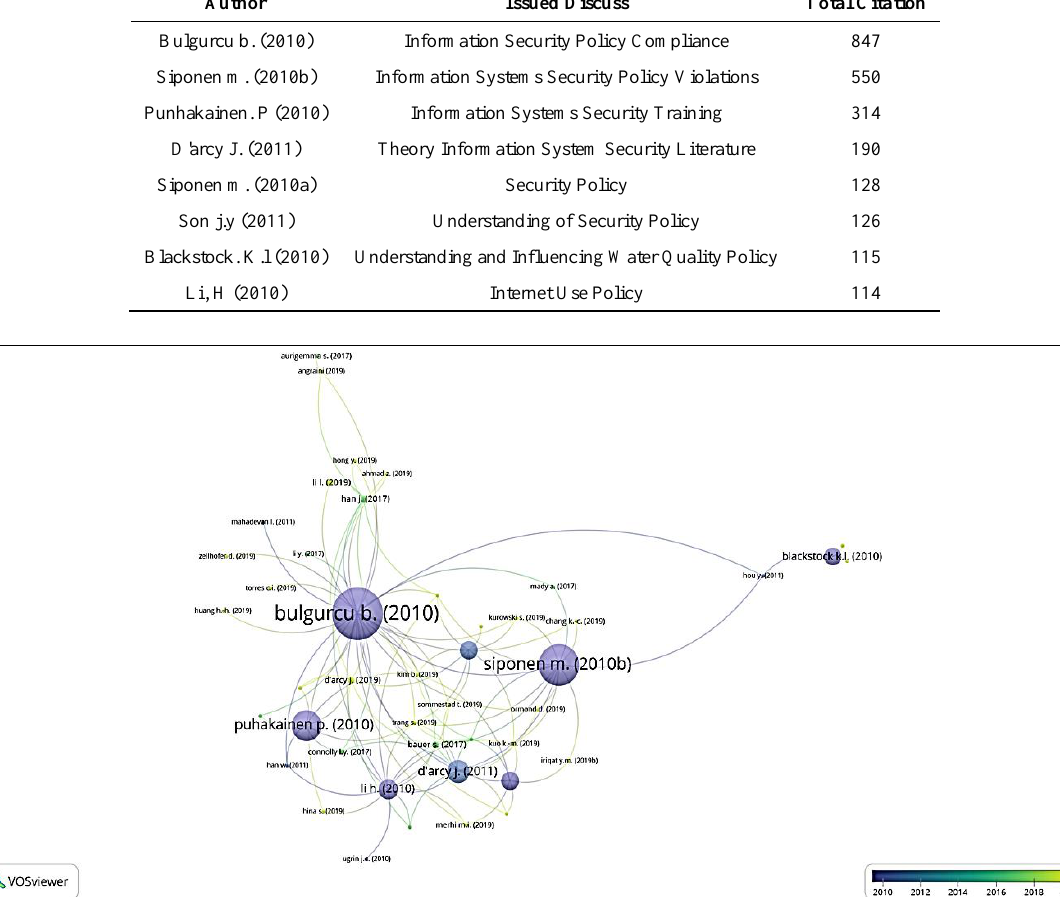
Table 3. Most cited theory-related policy research publications.